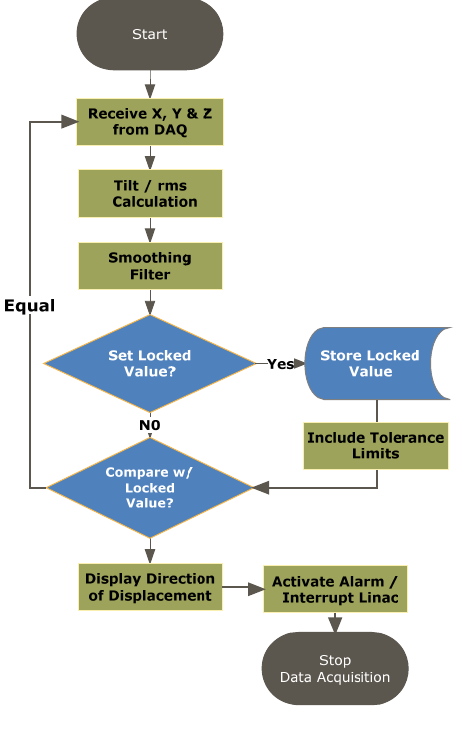
Figure 4. Flowchart of the signal processing algorithm used in APOMS.